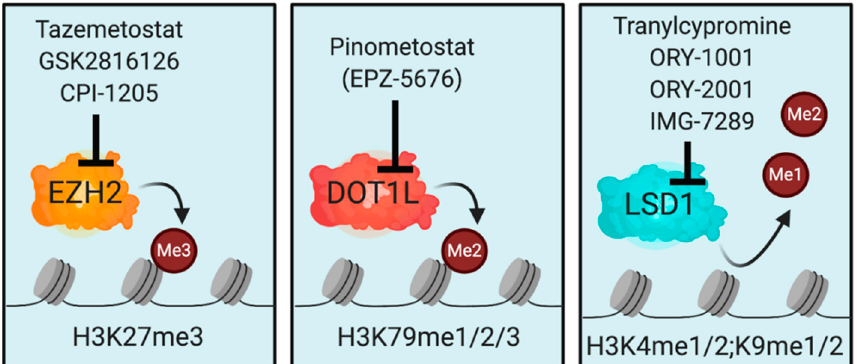
Figure 3. Enzymatic inhibitors of epigenetic writers and readers in clinical trials. Illustration of the targets of EZH2, DOT1L, and LSD1 ‐ inhibition with annotation of compounds that are approved by the FDA or entered clinical